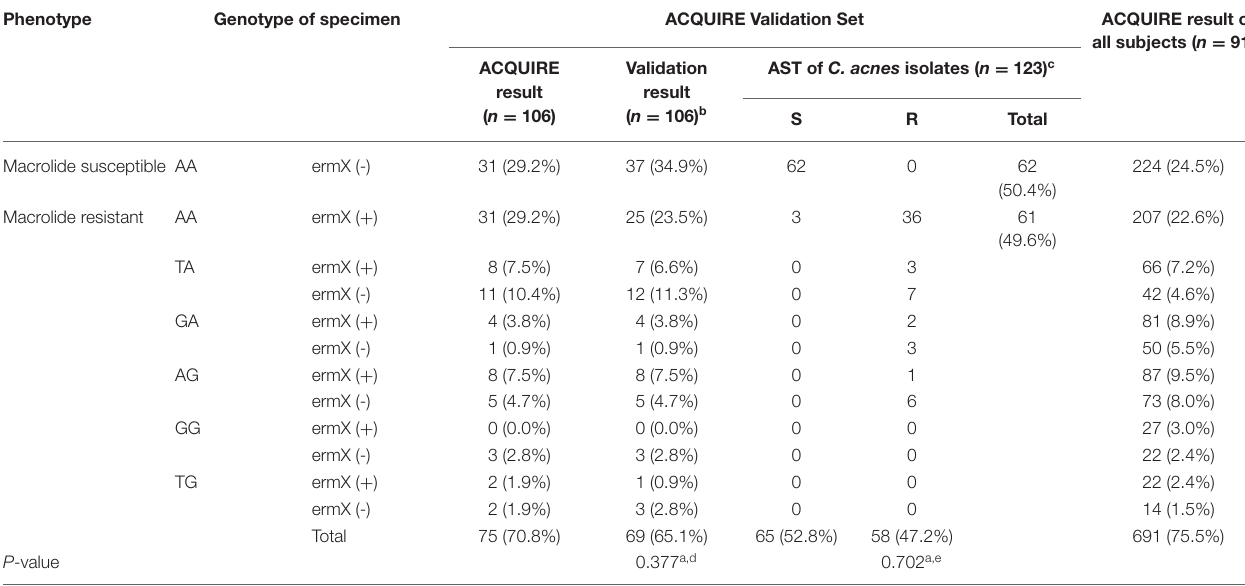
TABLE 1 | ACQUIRE is a sensitive and accurate method for detecting P. acnes resistance.